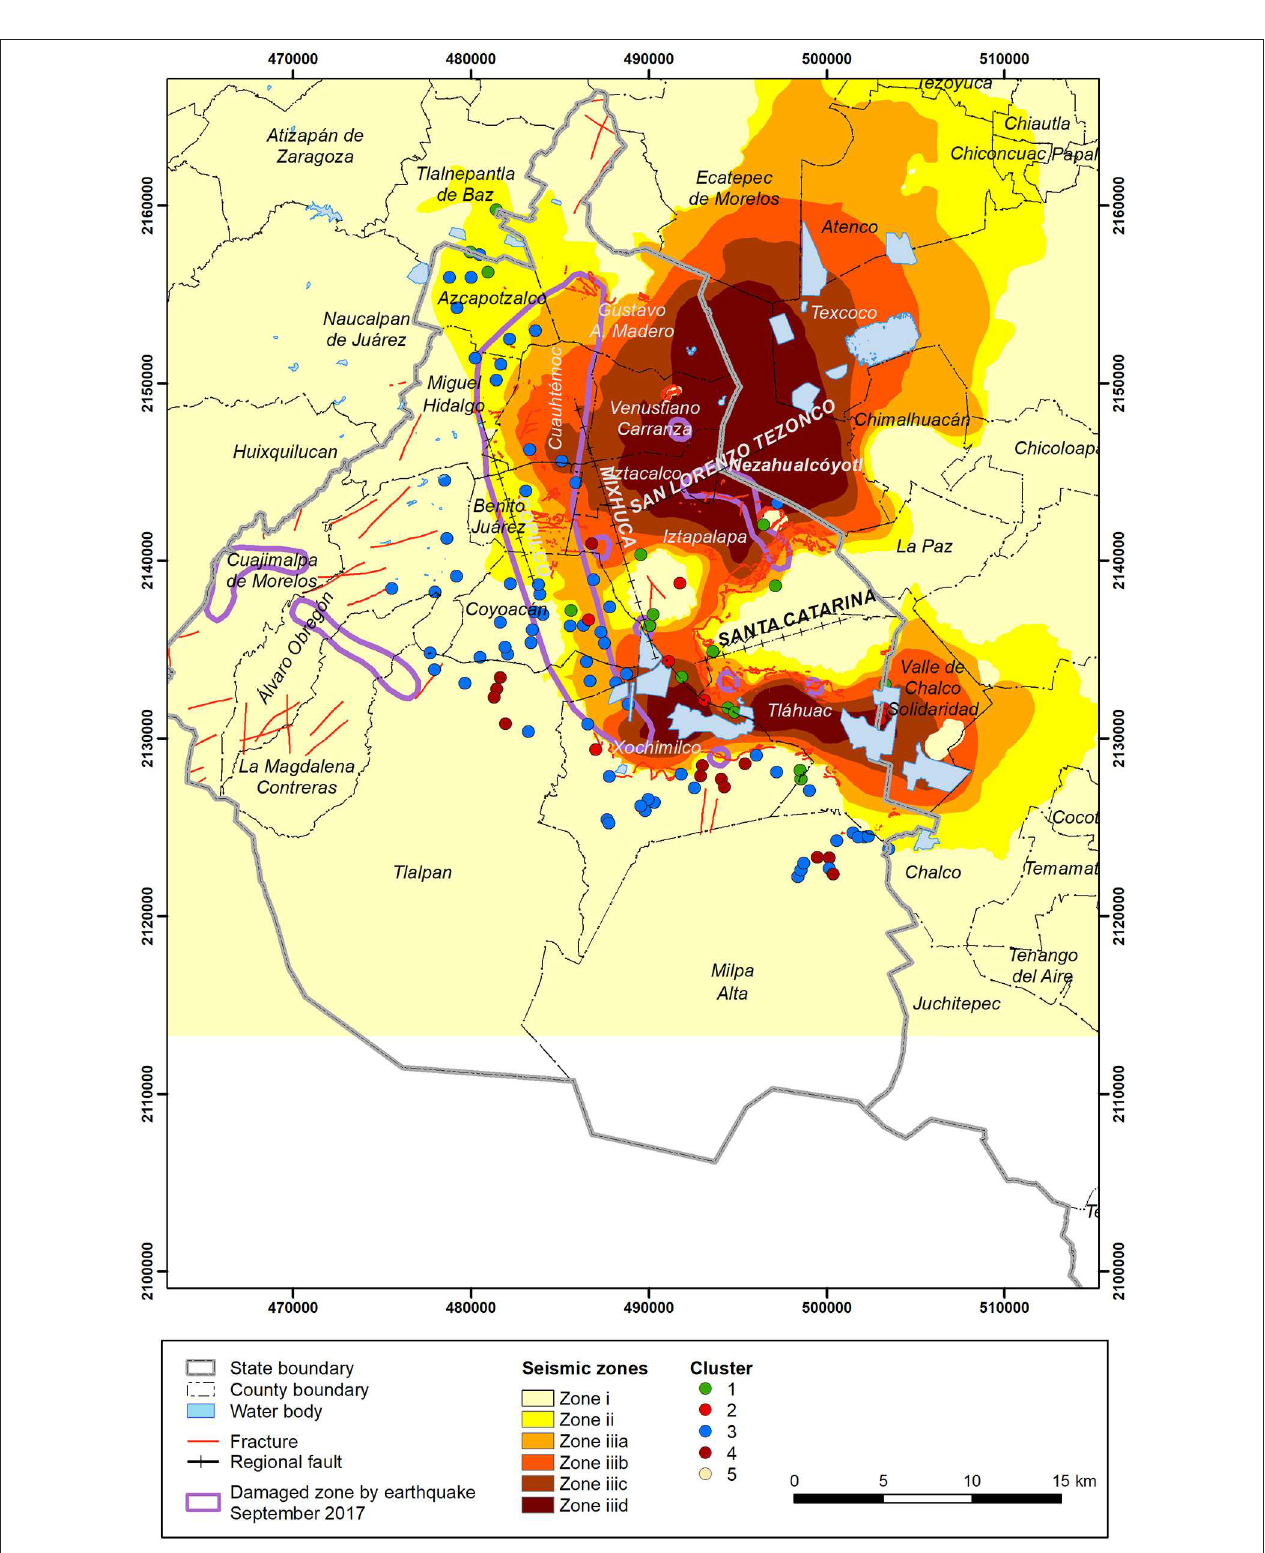
FIGURE 4 | Spatial representation of groundwater quality clusters, related to seismic zones, damaged zones in the 2017 earthquake (pink delimitation).